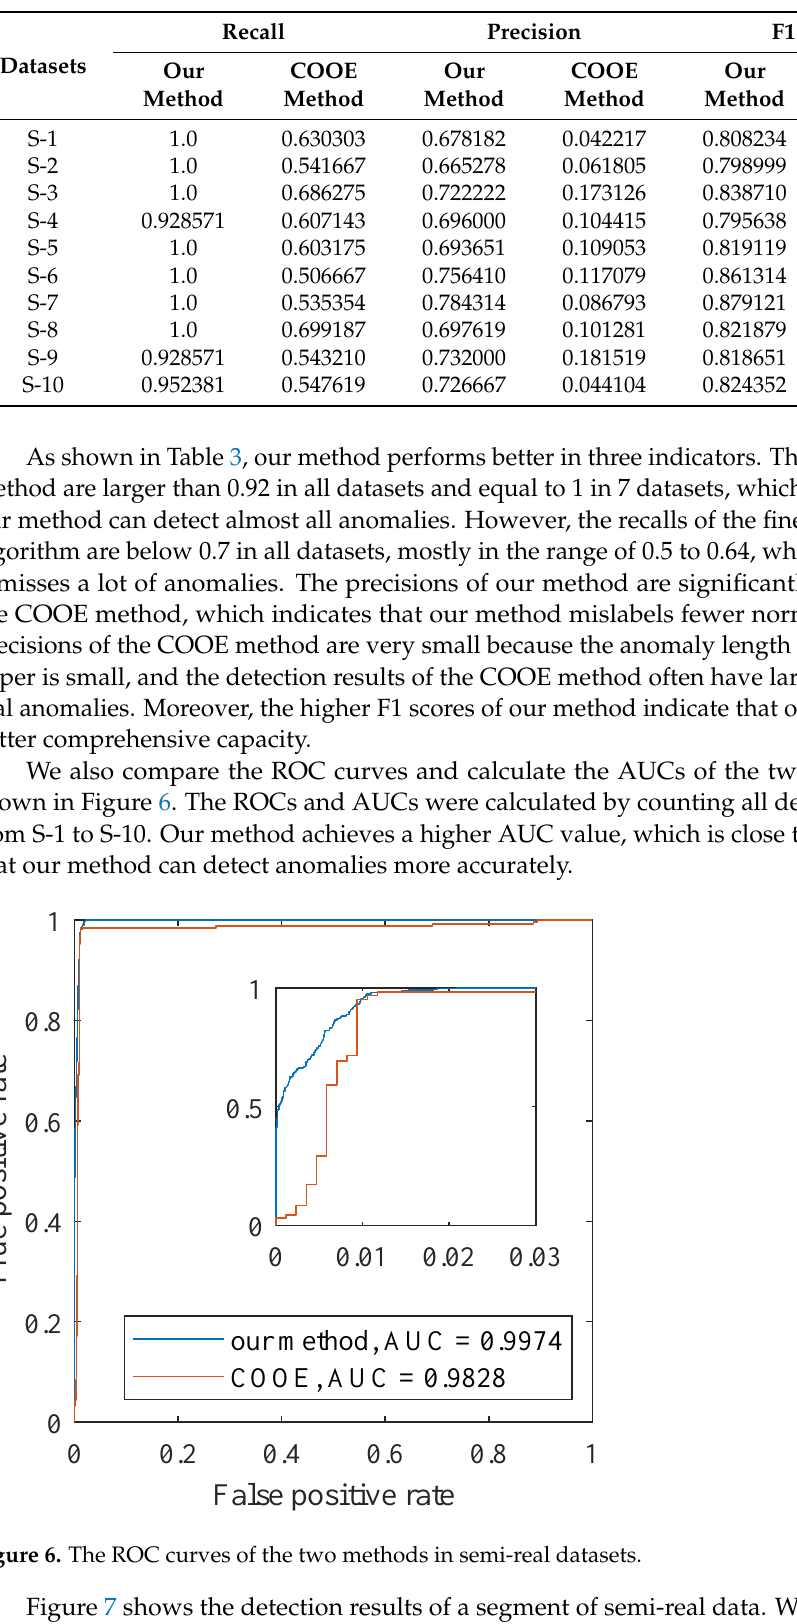
Table 3. Comparisons of detection results between the proposed method and the COOE method in semi-real datasets.